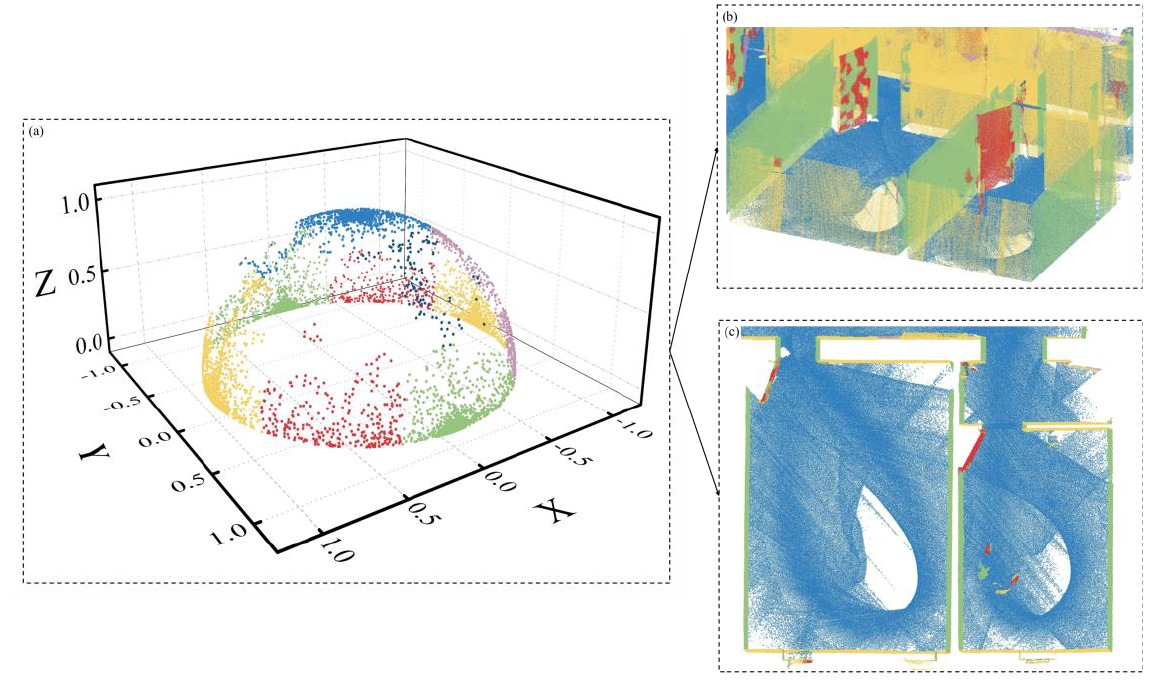
Figure 4. An example of plane segmentation using the saliency normal directions. ( a ) The K-mean- clustering results on a Gaussian half-sphere; and ( b ) and ( c ) the corresponding plane segmentation from different perspectives.